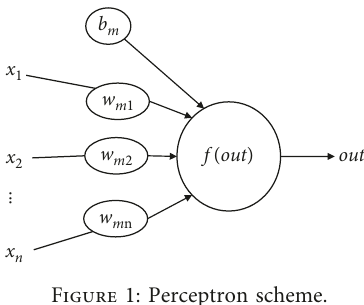
Figure 1: Perceptron